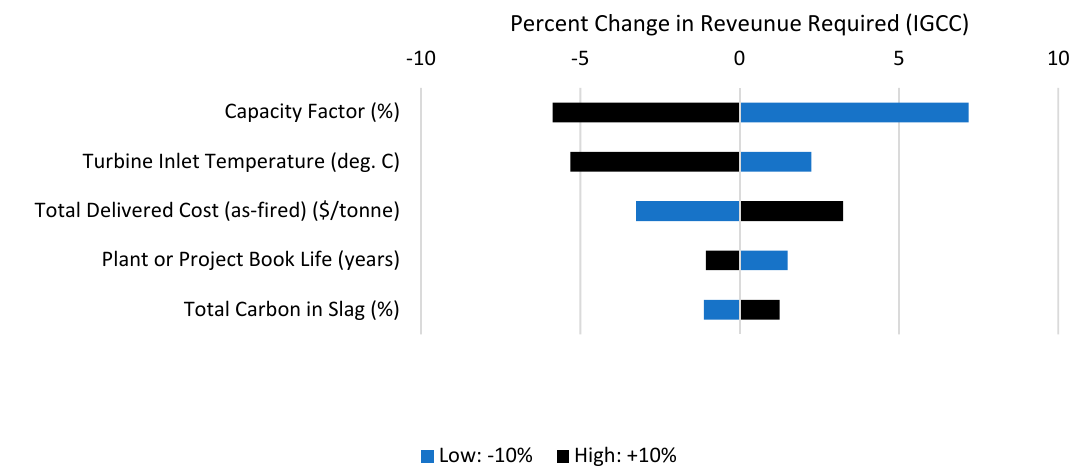
Figure 12. Sensitivity analyses of PC and IGCC powerplants running on pelletized pine. The bars in black represents results from increasing the input variable by 10%.